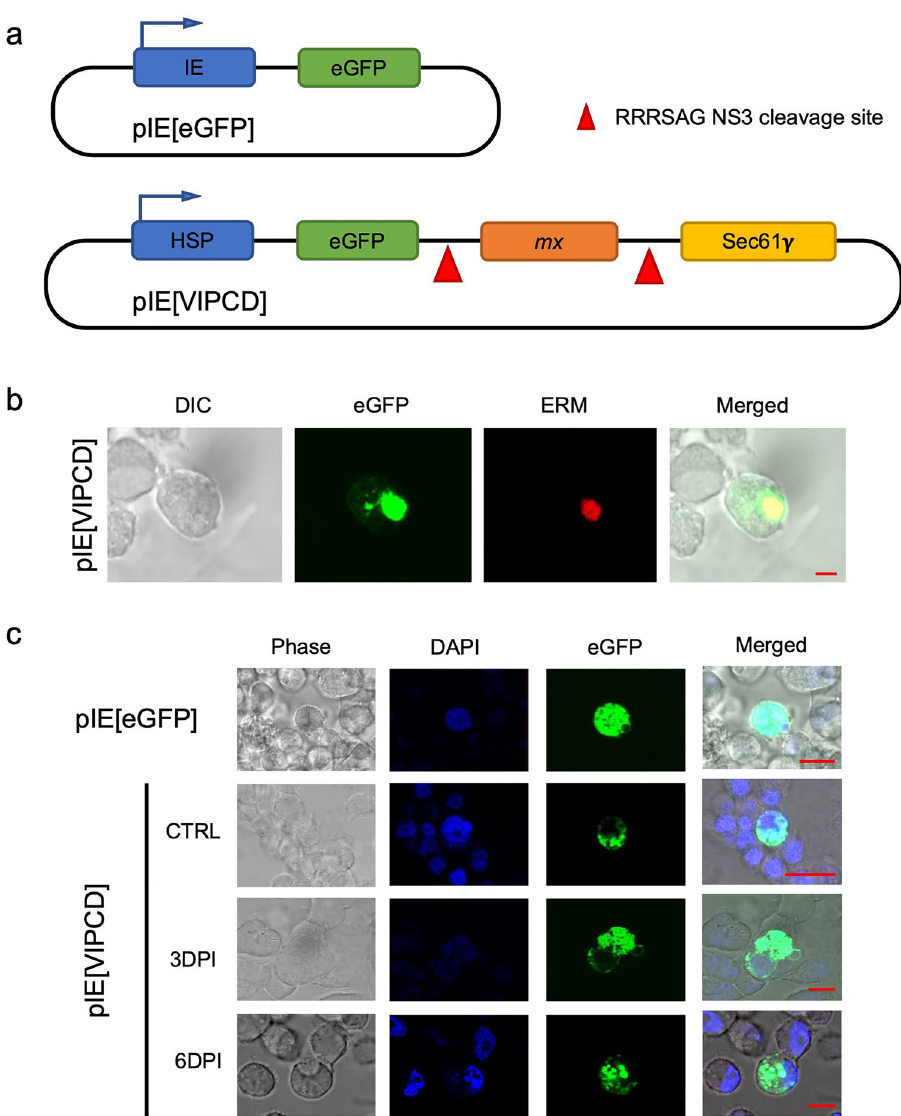
Figure 2. Co-localization of the VIPCD associated eGFP reporter at the endoplasmic reticulum of pIE[VIPCD] transfected C6/36 cells and release of the reporter following DENV-2 infection. ( a ) Schematic representation of the control pIE[EGFP] and pIE[VIPCD] plasmids used for the transfection of C6/36 cells. ( b ) Confocal images of C6/36 mosquito cells transfected with plasmid pIE[VIPCD] showing colocalization of the endoplasmic reticulum marker ERM and eGFP originating from VIPCD around the nuclear region of the cell. DIC, Differential Interference Contrast; eGFP, confocal image of eGFP expression; ERM, confocal image of endoplasmic reticulum marker expression; Merged, overlay of DIC, eGFP, and ERM. ( c ) Confocal images of eGFP expression in C6/36 cells transfected with plasmids pIE1[EGFP] or pIE1[VIPCD]; a non-infected control and pIE1[VIPCD] transfected cells following infection with DENV-2 (2.3 × 10 6 PFU/mL) at 3 and 6 DPI are shown. Phase, phase-contrast visualization; DAPI, marker for nuclear DNA; merged, overlay of phase, DAPI, and eGFP.